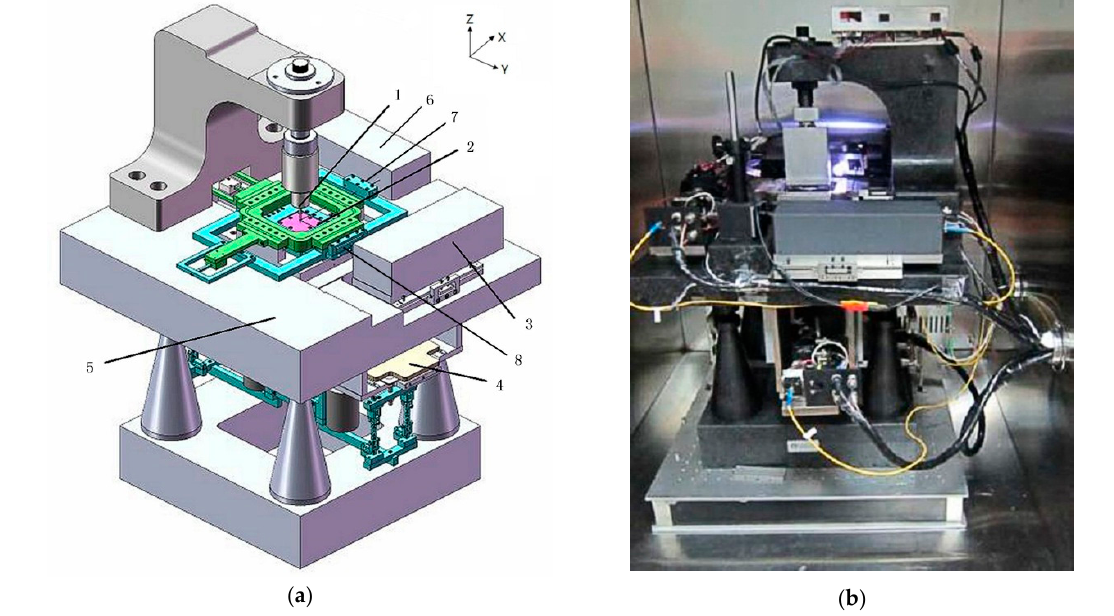
Figure 1. ( a ) schematic structure of the micro CMM (Coordinating Measuring Machines). ( b ) the photography of the mechanical assembly of the developed micro CMM. 1: Measuring probe, 2: XYZ stage, 3: Y ‐ interferometer, 4: Deadweight balance, 5: Granite base, 6: X ‐ interferometer, 7: Reflection stage, 3: Y -interferometer, 4: Deadweight balance, 5: Granite base, 6: X -interferometer, 7: Reflection mirror of X ‐ interferometer, 8: Reflection mirror of Y ‐ interferometer. mirror of X -interferometer, 8: Reflection mirror of Y